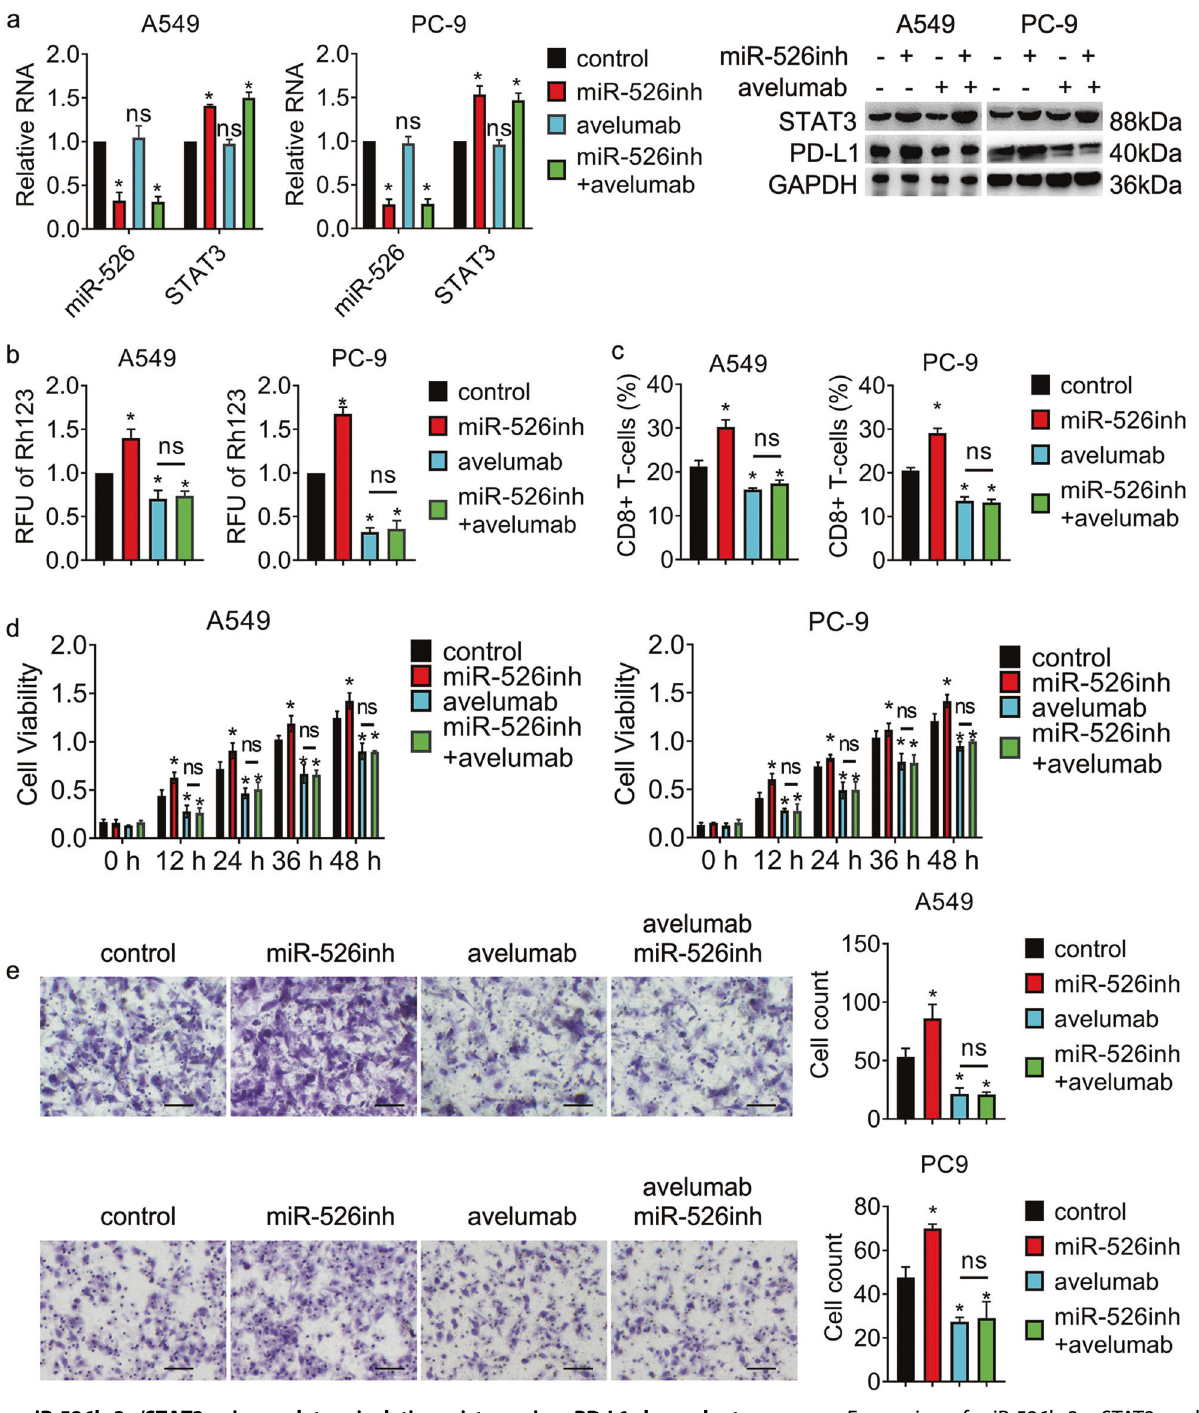
Fig. 5 miR-526b-3p/STAT3 axis regulates cisplatin resistance in a PD-L1-dependent manner. a Expression of miR-526b-3p, STAT3, and PD- L1 is accessed by qRT-PCR and western blot, separately. b The activity of MDR1 is measured by rhodamine123 ef fl ux assay. RLU relative fl uorescence of unit. c The percentage of CD8 positive T-cells in the indicated cells are accessed by fl ow cytometry analysis. d The viability of the indicated cells is accessed by MTT assay. e The motility of the indicated cells is detected by transwell migration assay. Scale bar, 100 µm. *, P < 0.05 vs. control. ns no signi fi cance vs